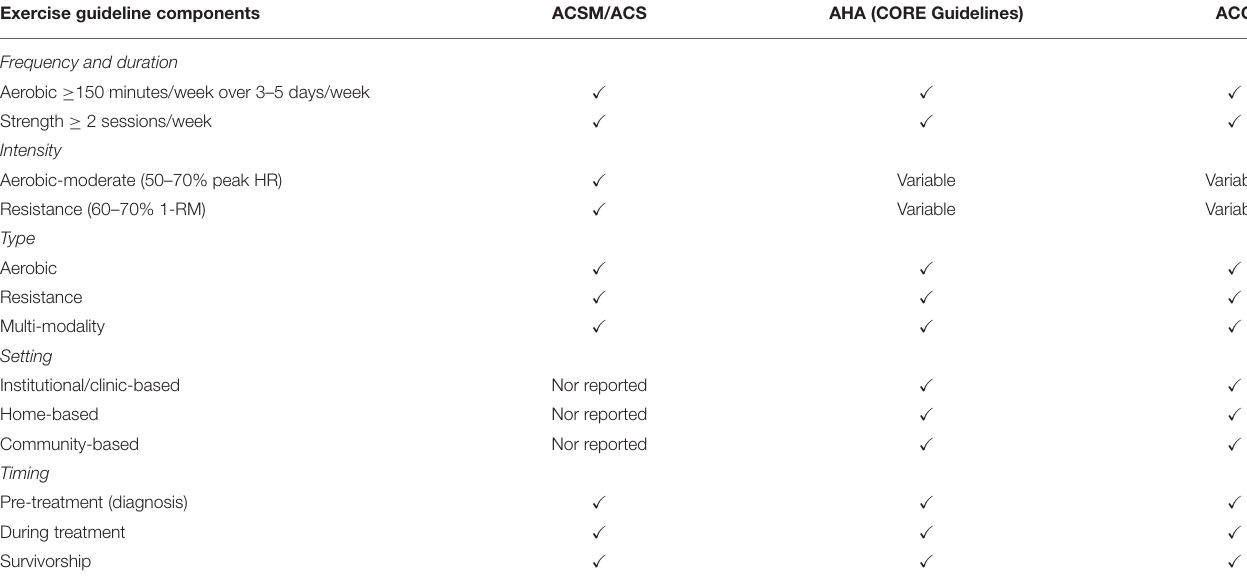
TABLE 1 | Comparison of the exercise guidelines recommended by the American College of Sports Medicine (ACSM)/American Cancer Society (ACS), American Heart Association (AHA), and American College of Cardiology (ACC). Exercise guideline